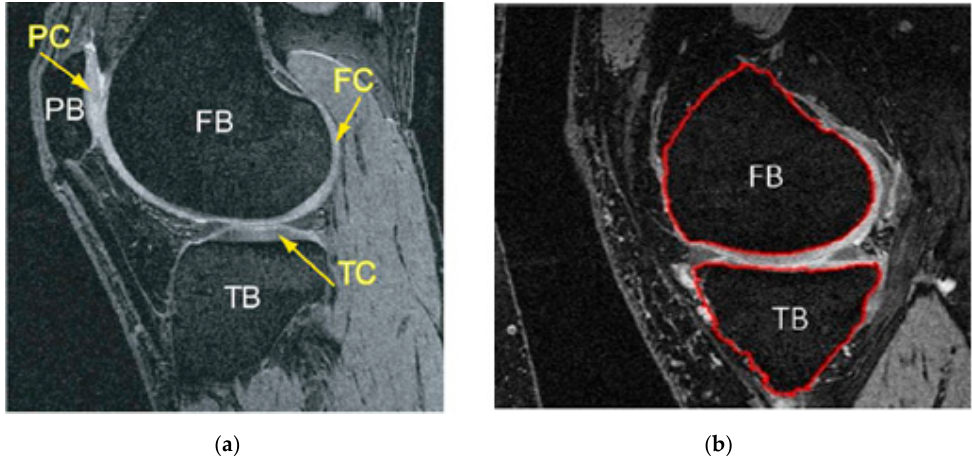
Figure 2. Knee bone segmentation has benefits over other tissues because of its location and anatomical size. ( a ) Illustrates the MR image of a knee joint—patella, femur, and tibia bones, readily apparent with the accompanying cartilage surfaces. TB = tibia bone, FB = femoral bone, PC = patellar cartilage, FC = femoral cartilage, TC= tibia cartilage. ( b ) Shows segmented tibia (TB) and femur (FB), which usually have better demarcation [19].